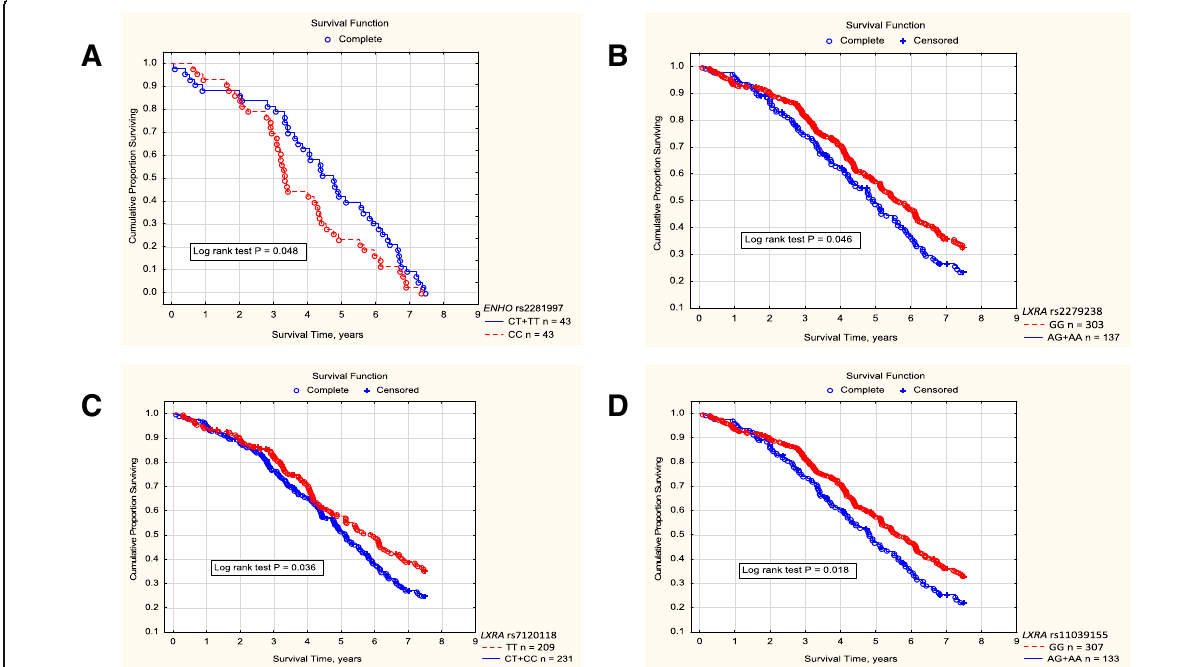
Fig. 1 Cumulative proportion surviving of HD patients with respect to selected ENHO and LXRA SNPs. a Cardiovascular mortality among HD patients showing atherogenic dyslipidemia with respect to ENHO rs2281997 polymorphic variants (the dominant model of inheritance). Cardiovascular mortality was analyzed among 227 patients who started the prospective study showing atherogenic dyslipidemia. Through 7.5 years of follow-up, 86 patients died due to cardiovascular complications (43 subjects possessed the CC genotype and 43 patients were harboring the T allele of ENHO rs2281997). Cardiovascular mortality was analyzed using the Kaplan-Meier method with the subsequent log-rank test. In the Cox analysis, the T allele was associated with approximately 1.6-fold lower cardiovascular mortality in HD patients with atherogenic dyslipidemia (HR 0.64, 95% CI 0.42 - 0.99, P = 0.047). b Survival probability in HD patients with respect to LXRA rs2279238 polymorphic variants (the dominant model of inheritance). Survival probability was analyzed using the Kaplan-Meier method in 440 patients prospectively followed through 7.5 years. In the Cox analysis, HR was 1.30, 95% CI 1.01 - 1.67, P = 0.042. c Survival probability in HD patients with respect to LXRA rs7120118 polymorphic variants (the dominant model of inheritance). Survival probability was analyzed using the Kaplan-Meier method in 440 patients prospectively followed through 7.5 years. In the Cox analysis, HR was 1.29, 95% CI 1.02 - 1.65, P = 0.037. d Survival probability in HD patients with respect to LXRA rs11039155 polymorphic variants (the dominant model of inheritance). Survival probability was analyzed using the Kaplan-Meier method in 440 patients prospectively followed through 7.5 years. In the Cox analysis, HR was 1.36, 95% CI 1.05 - 1.75, P = diabetic nephropathy (HR: 2.10, 95% CI: 1.41 – 3.13, P =